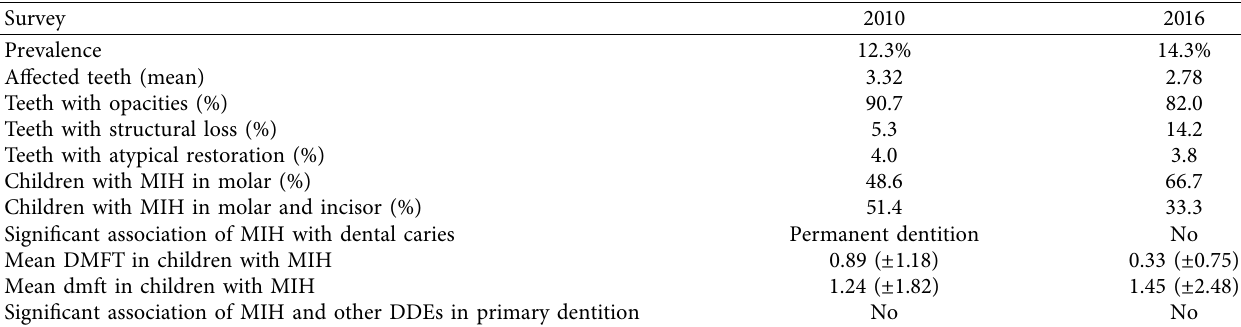
Table 6: Descriptive data of two prevalence studies carried out in the city of Araraquara, with an interval of 6 years.